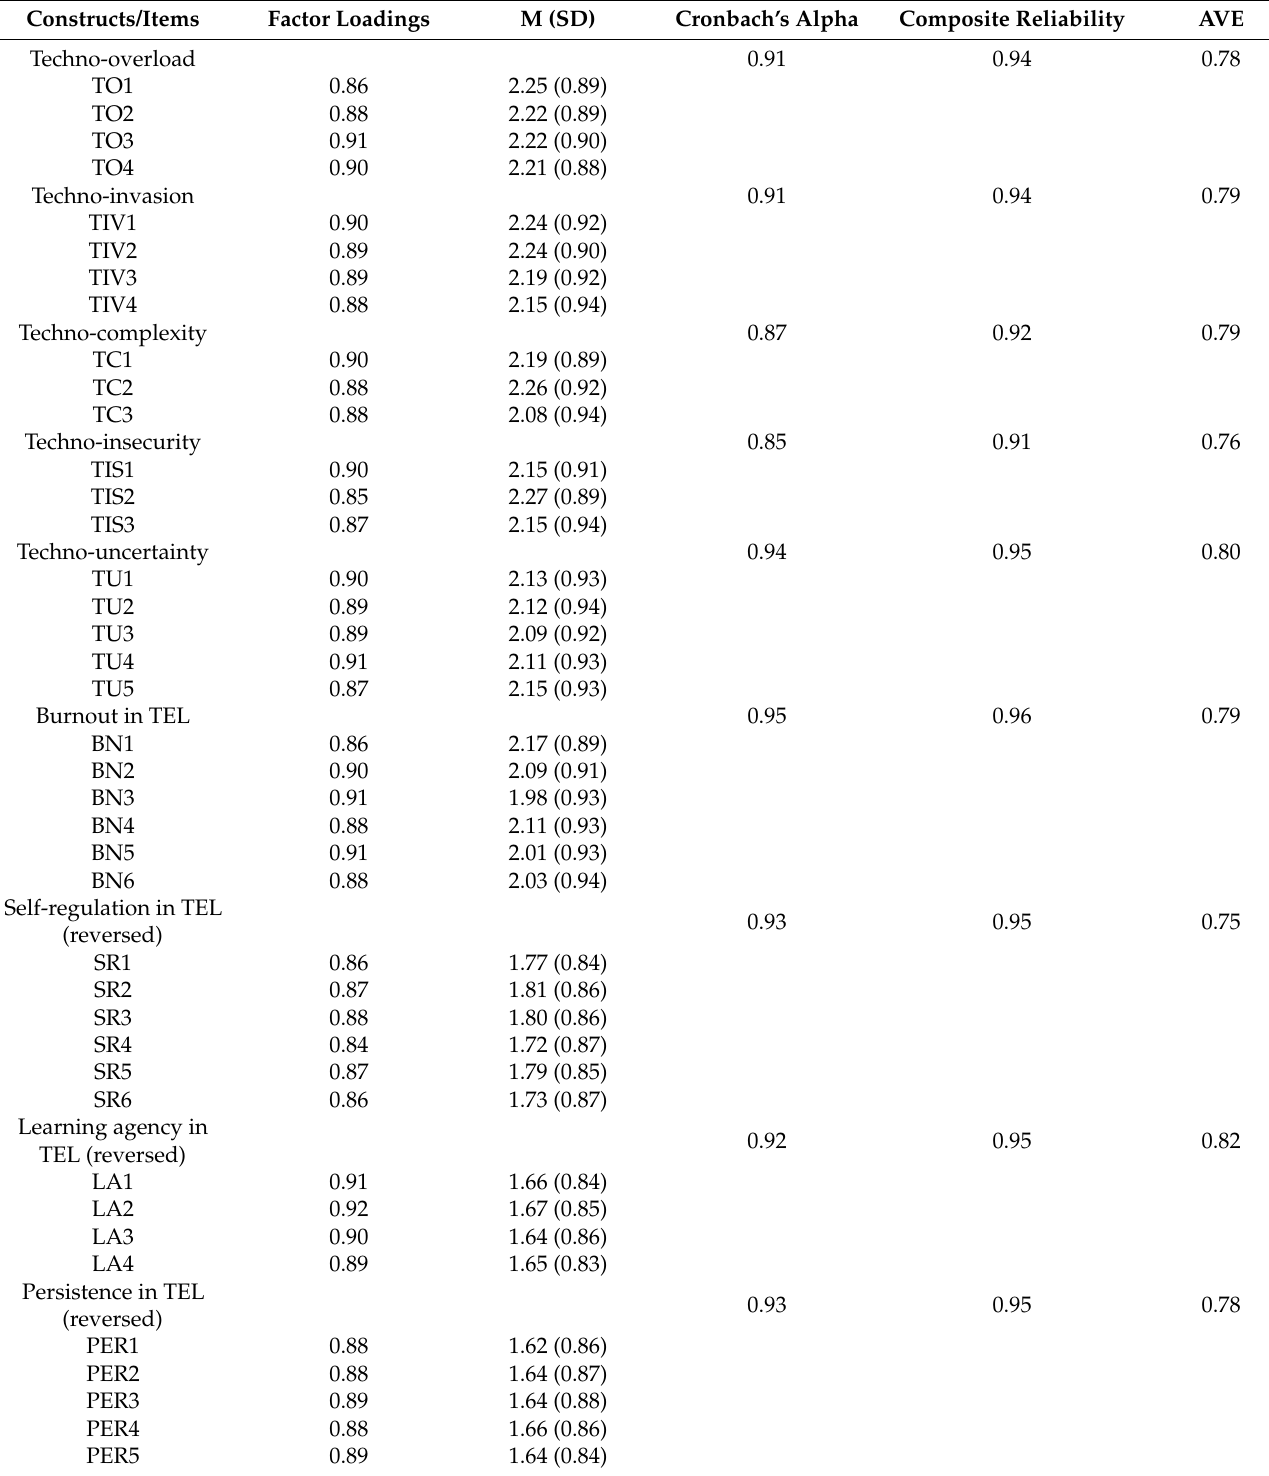
Table 1. Cronbach’s alpha, composite reliability, average variance extracted (AVE), and factor loadings of the SSO model.